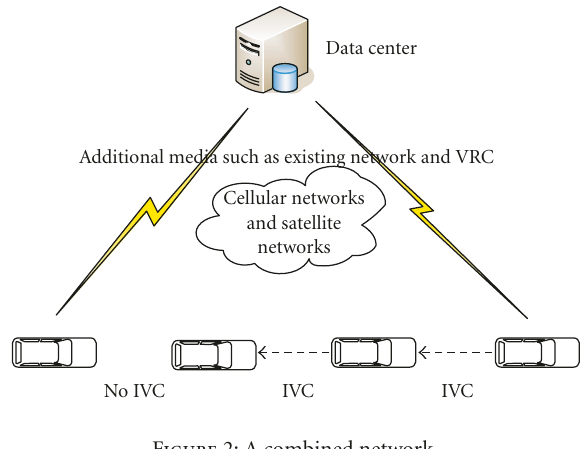
Figure 2: A combined network.